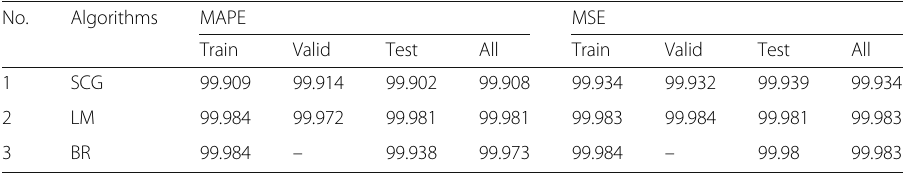
Table 3 Accuracy (in %) comparison between MAPE and MSE for tick data No. Algorithms